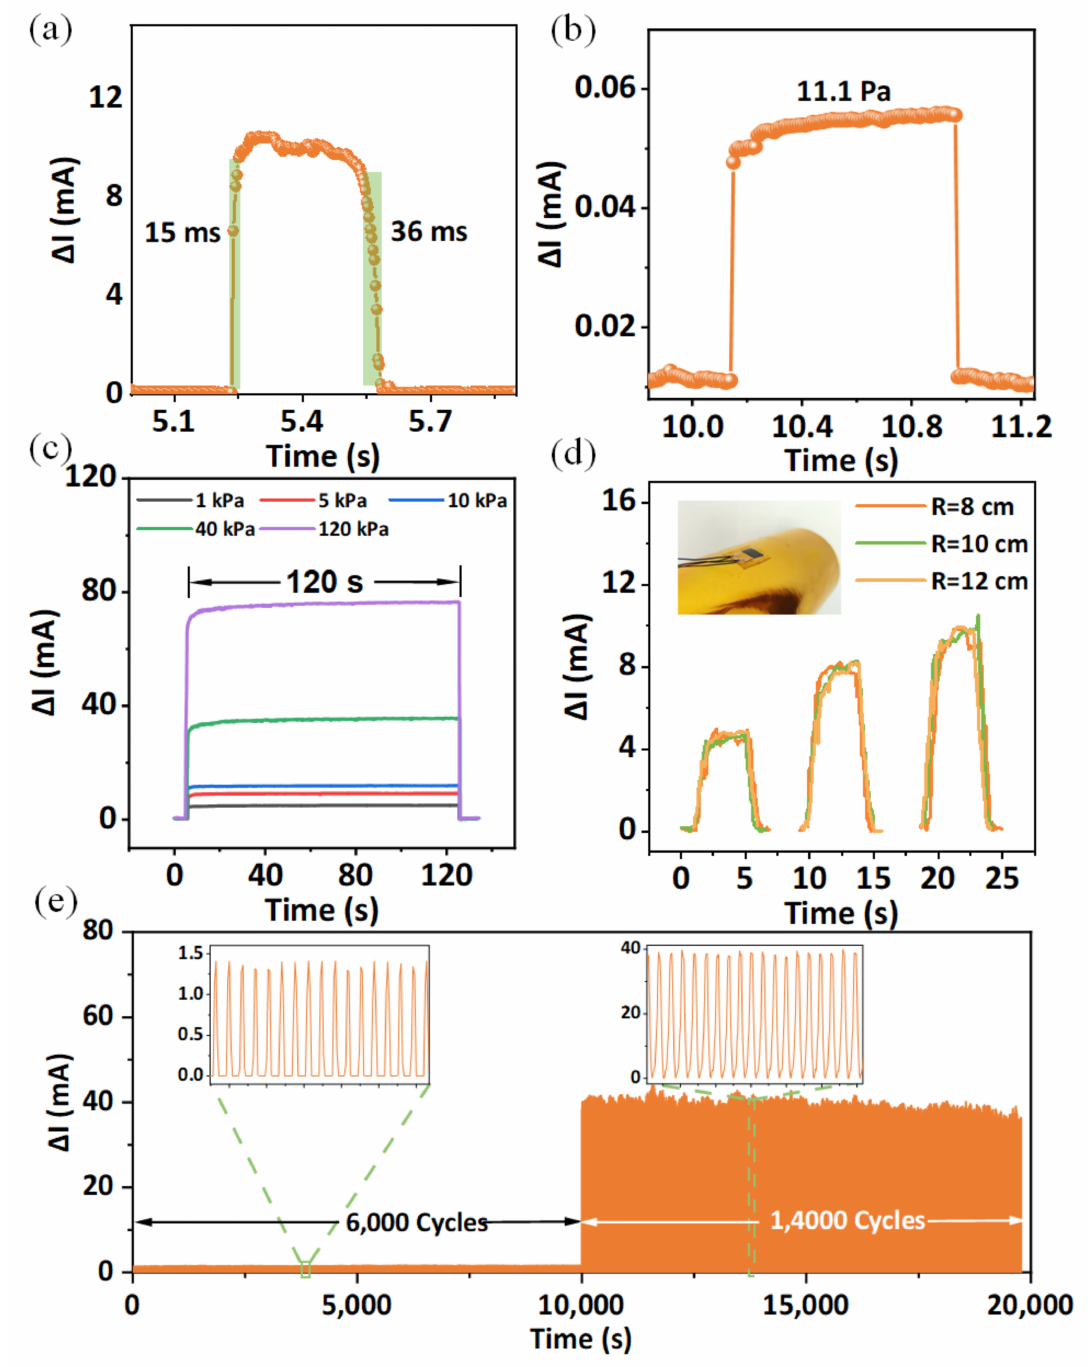
Figure 4. ( a ) Outlined response and relaxation time under a pressure of 10 kPa; ( b ) minimum detection pressure is 11.1 Pa; ( c ) response of FPS under different pressure for 120 s; ( d ) The FPS were tested on the sides of cylinders with different radii; ( e ) long-term durability over 6000 cycles under a pressure of 1 kPa and 14,000 cycles under a pressure of 50